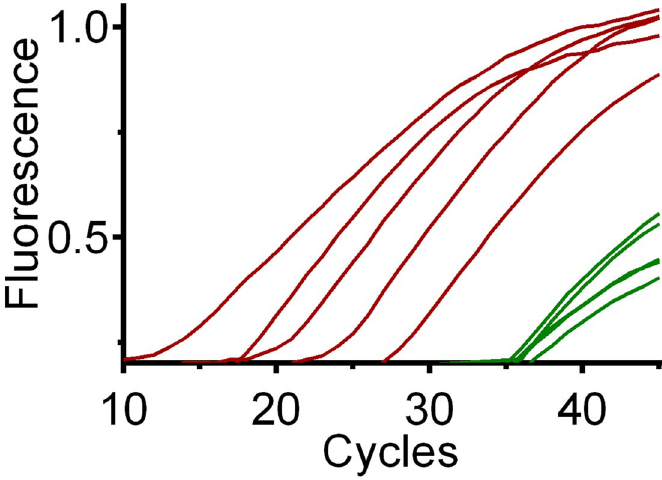
Figure 5. Canissp. qPCR amplification of 14 samples (green), 5 serial dilutions (red) and NTC (no template control, black). NTC are not visible because they did not amplify and rise above the